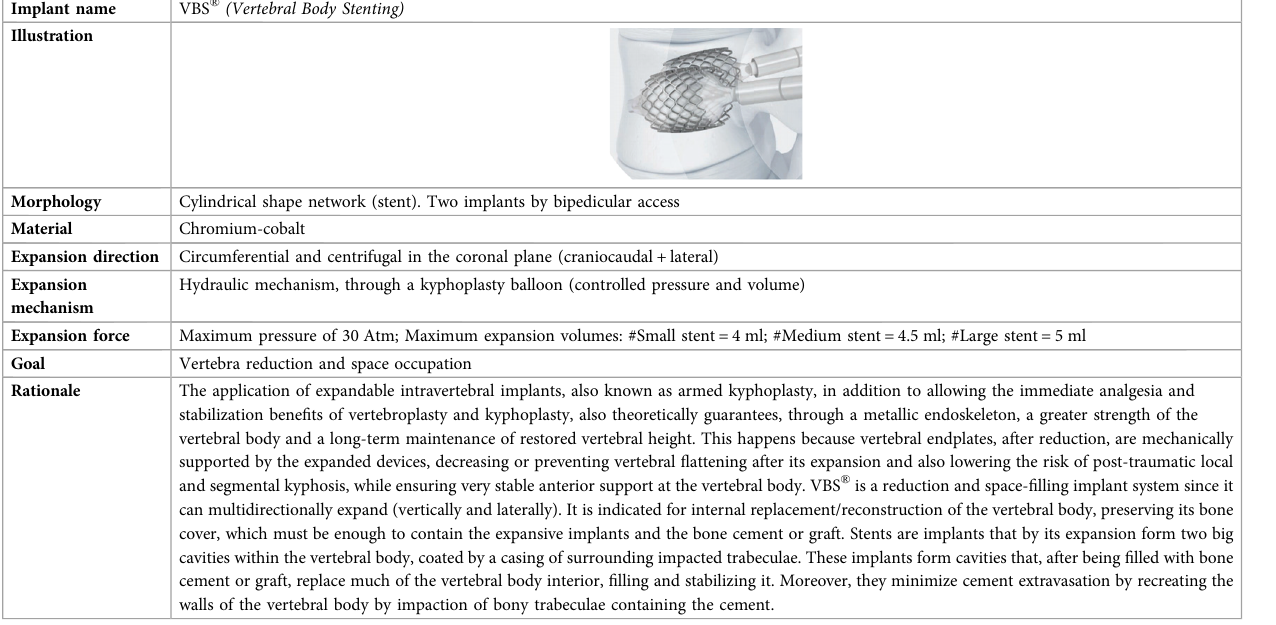
TABLE 1 Biomechanical characteristics of the expansive intravertebral implants VBS ® ( vertebral body stenting ) (12 – 22). Implant